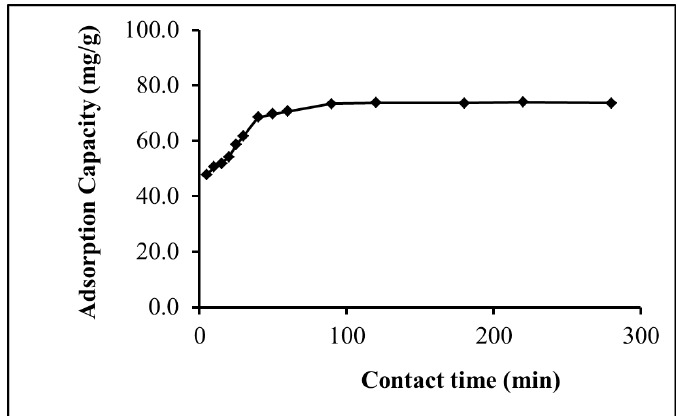
Figure 4. Effect of contact time on Hg(II) adsorption by IL-ACMRW (ionic liquid modified activated carbon from mixed recyclable waste), adsorbent dose 0.5 m/L, Hg(II) solution dose of 20 mg/L at pH 4.